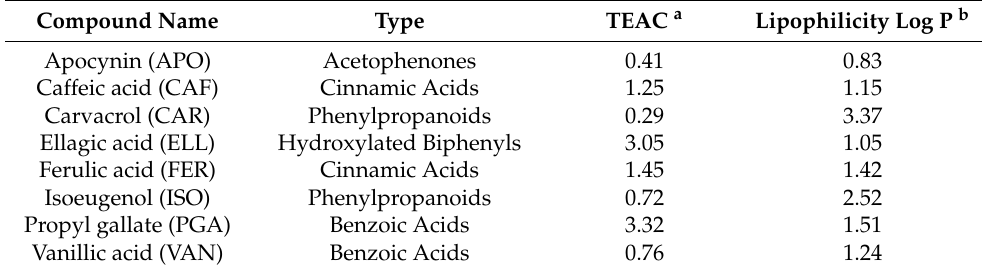
Figure 1. Structure of tested compounds. Table 1. List of tested compounds listed according to antioxidant activity and